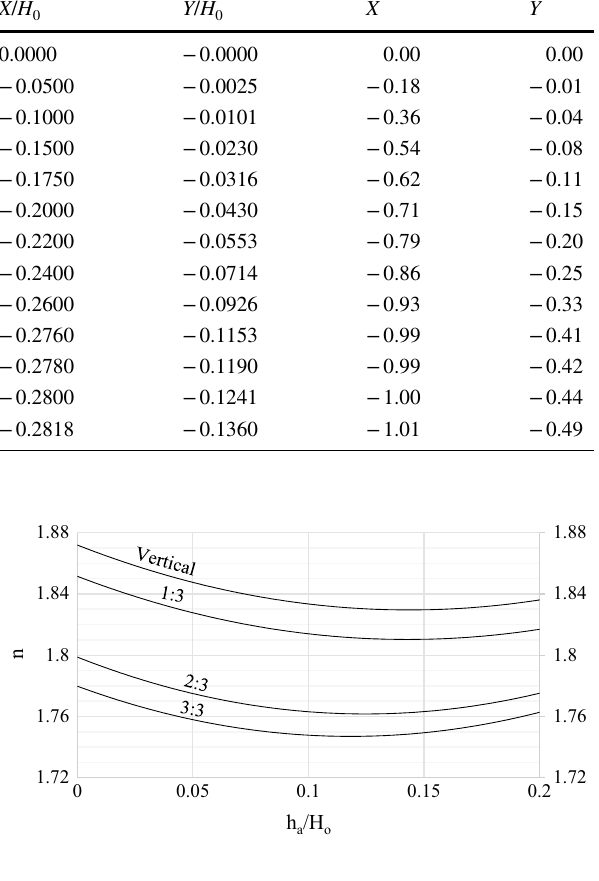
Fig. 9 Value of n in Eq. 2